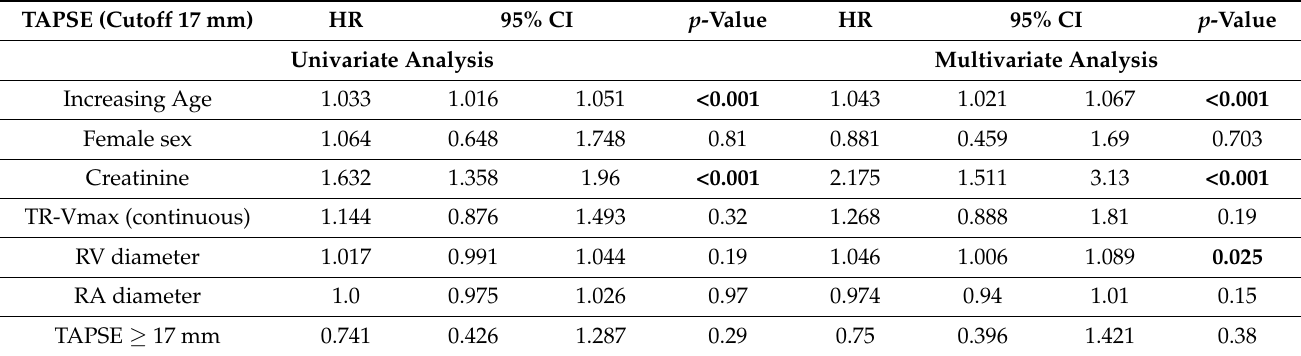
Table 2. Cox proportional hazard regression analysis to assess the effect of different RVF parameters on survival during 2-year